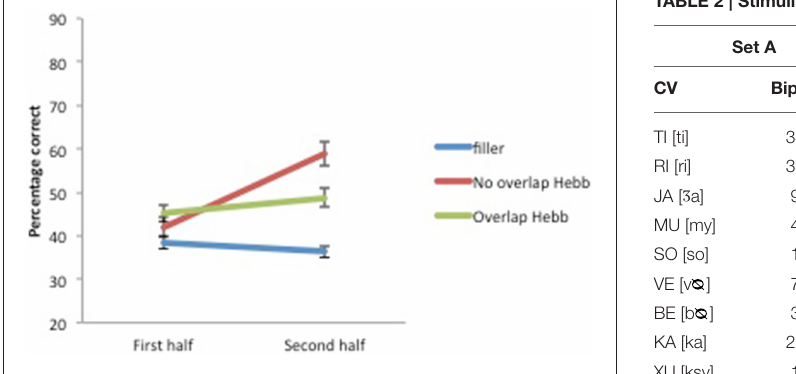
TABLE 2 | Stimuli material for Experiment